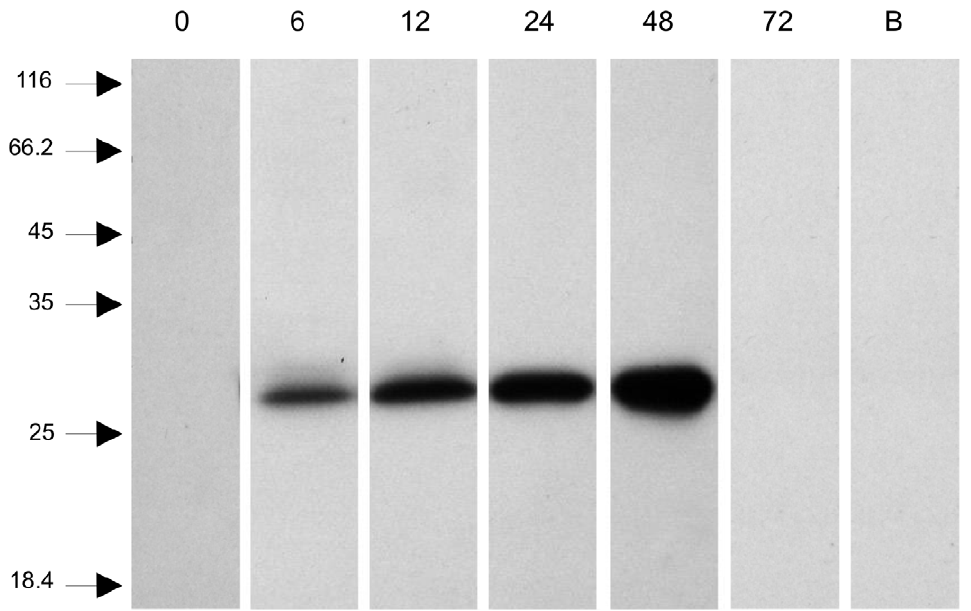
Figure 2. Western blot performed with anti-Lltryp1-peptide antibody. 0 : non-fed female; 6 to 72 : females obtained at 6, 12, 24, 48 and 72 hours ABF; B : 2 m L of hamster blood. Samples corresponding to 2 insect midguts were loaded in lanes 0 to 72 . Molecular mass standard values (kDa) are indicated by numbers and arrows on the left side of the figure.